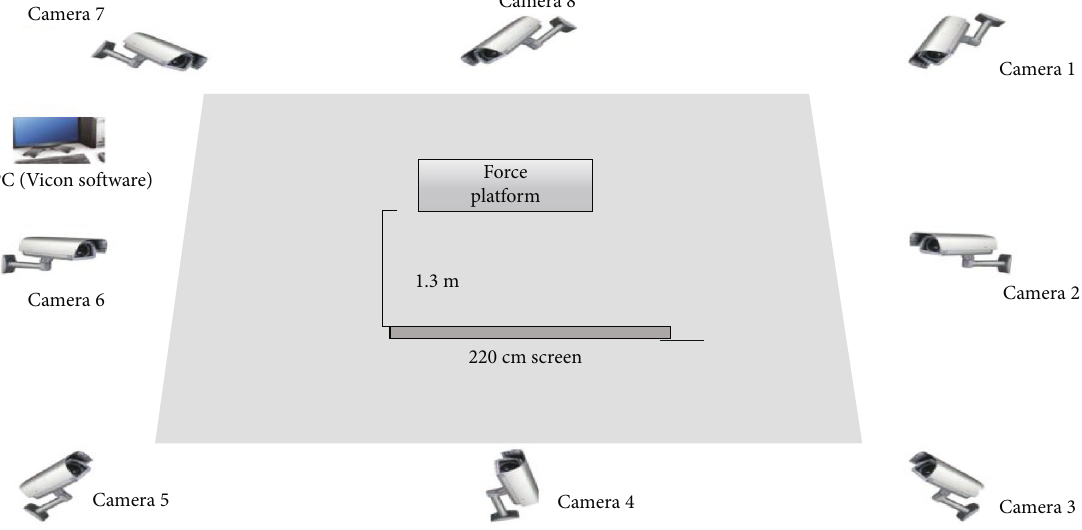
Figure 1: Overview of the experimental setup.